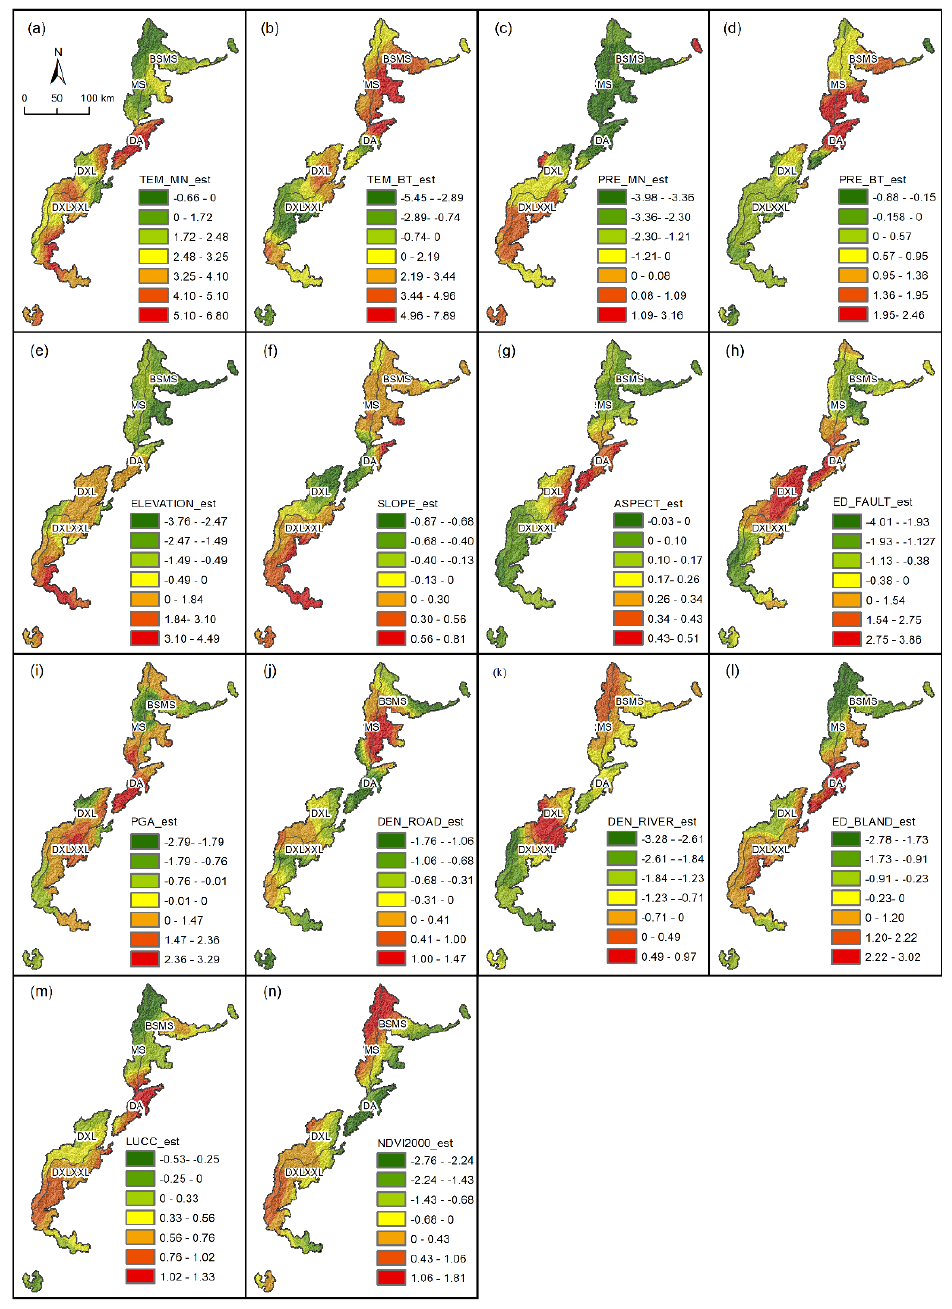
Figure 10. Driving factor estimation coefficient in GWR Model. ( a ) Temperature mean value; ( b ) temperature slope value; ( c ) precipitation mean value; ( d ) precipitation slope value; ( e ) elevation; ( f ) slope; ( g ) aspect; ( h ) Euclidean distance from fault; ( i ) peak ground acceleration; ( j ) road density; ( k ) river density; ( l ) Euclidean distance from built-up land; ( m ) land-use change index; ( n ) NDVI in 2000.